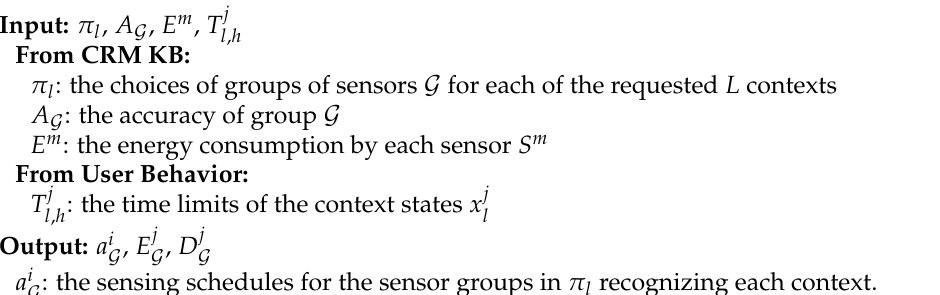
Algorithm 2 Offline algorithm for sensor